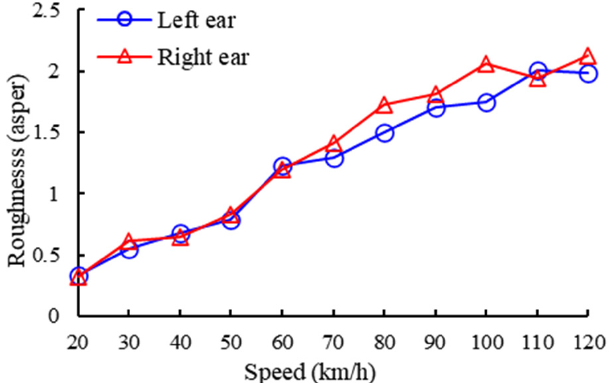
Figure 8. Interior noise roughness in the EV as a function of the vehicle’s speed.